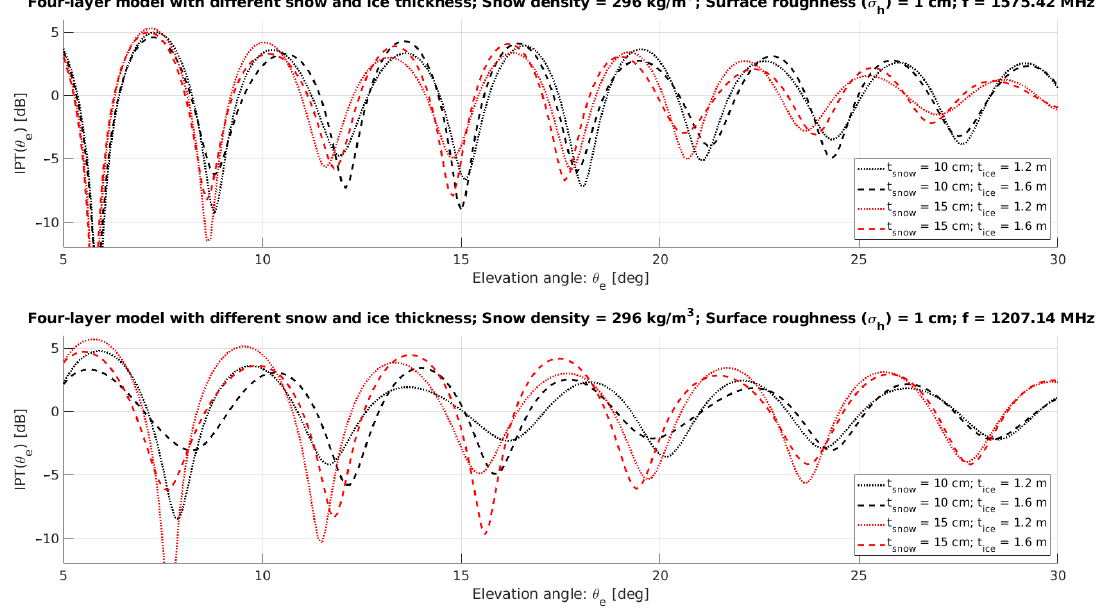
Figure 6. Comparison of the RHCP four-layer model at 1575.42 MHz ( top ) and 1207.14 MHz ( bottom ), using four different combinations of snow and ice thickness.